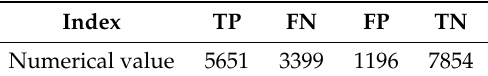
Table 28. Forecast indices value.